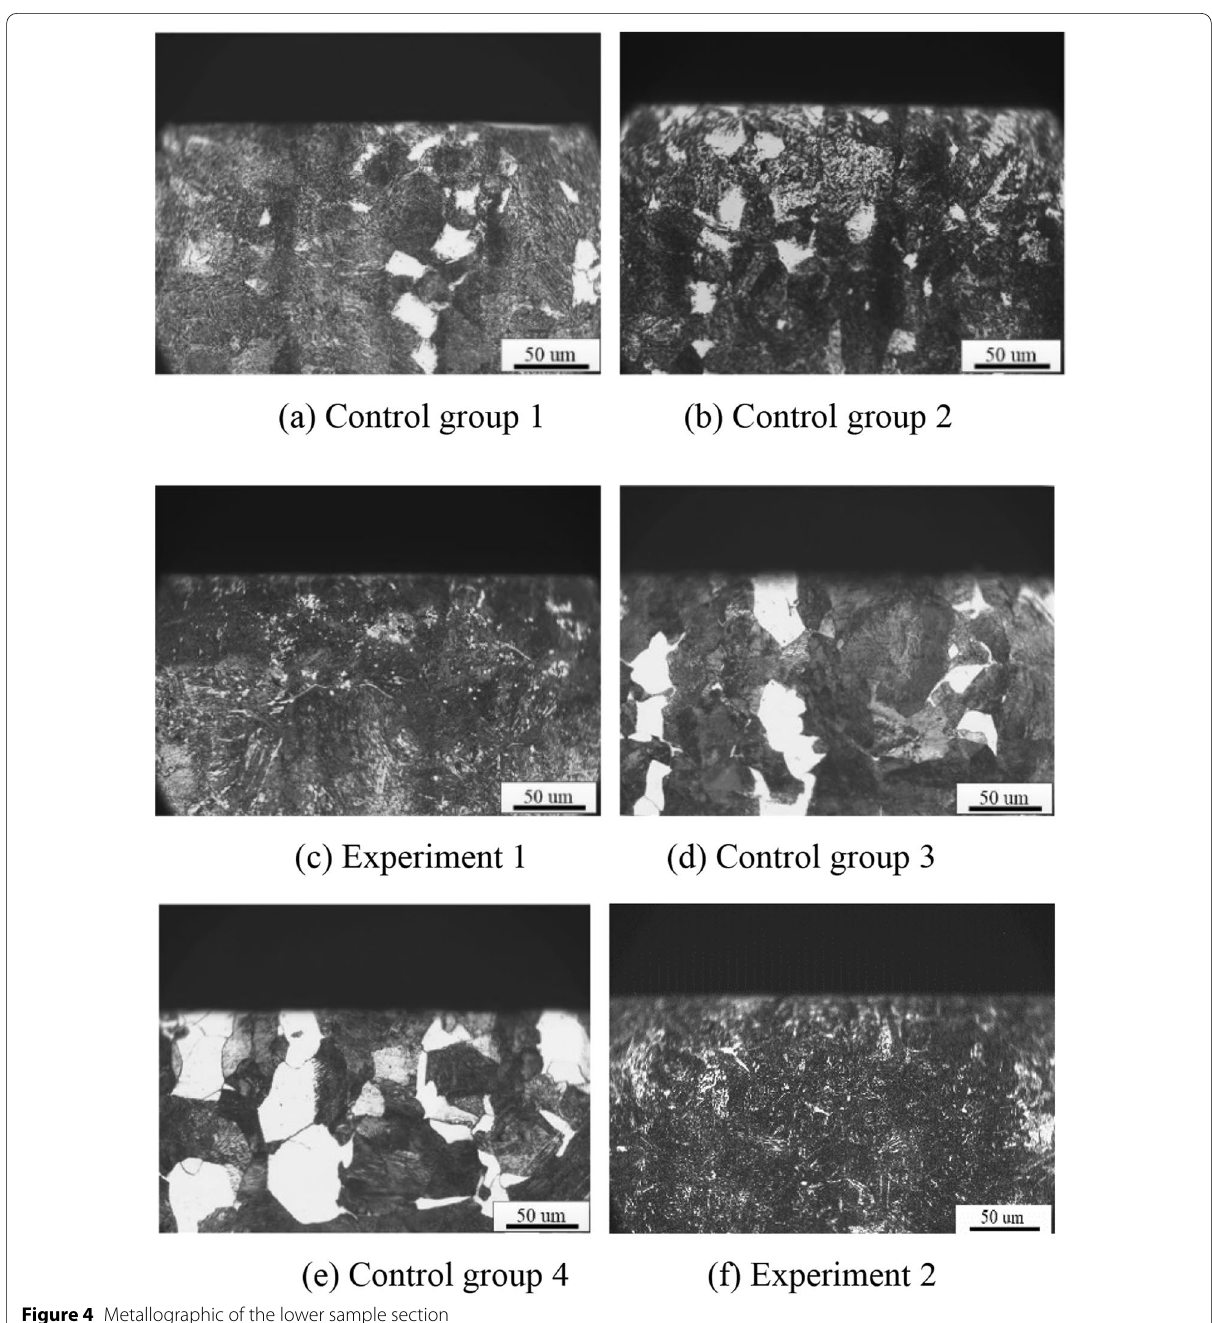
Figure 4 Metallographic of the lower sample section